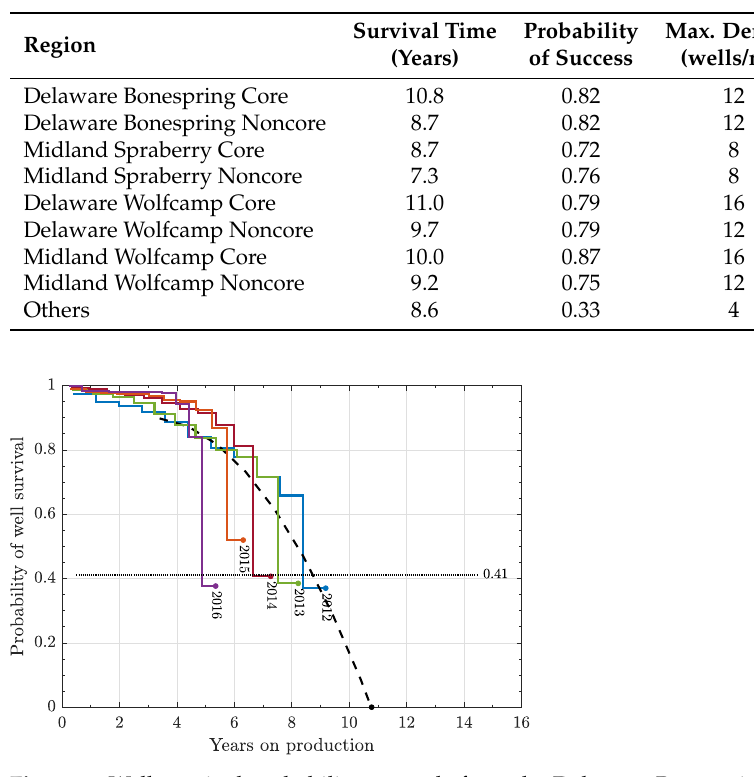
Table 3. Summary of maximum survival time, probability of success, maximum well density, and infill potential for each Permian region.